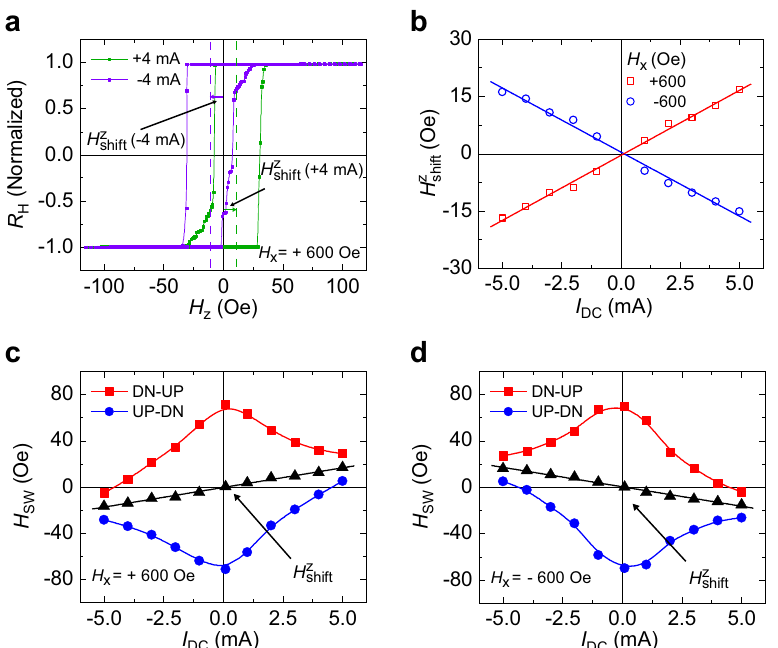
Fig. 3 Evaluation of the z component of the spin – orbit effective fi eld on the magnetic Néel DWs. a The normalized out-of-plane Hall curves measured under a fi xed in-plane magnetic fi eld of H x = + 600 Oe and opposite d.c. currents of ± 4mA. b The H z solid lines are linear fi ttings to the data. c , d The switching fi elds H SW for down-to-up (DN-UP, red squares) and up-to-down (UP-DN, blue circles) magnetization reversals as a function of I DC with H x = + 600 Oe and H x = − 600 Oe,